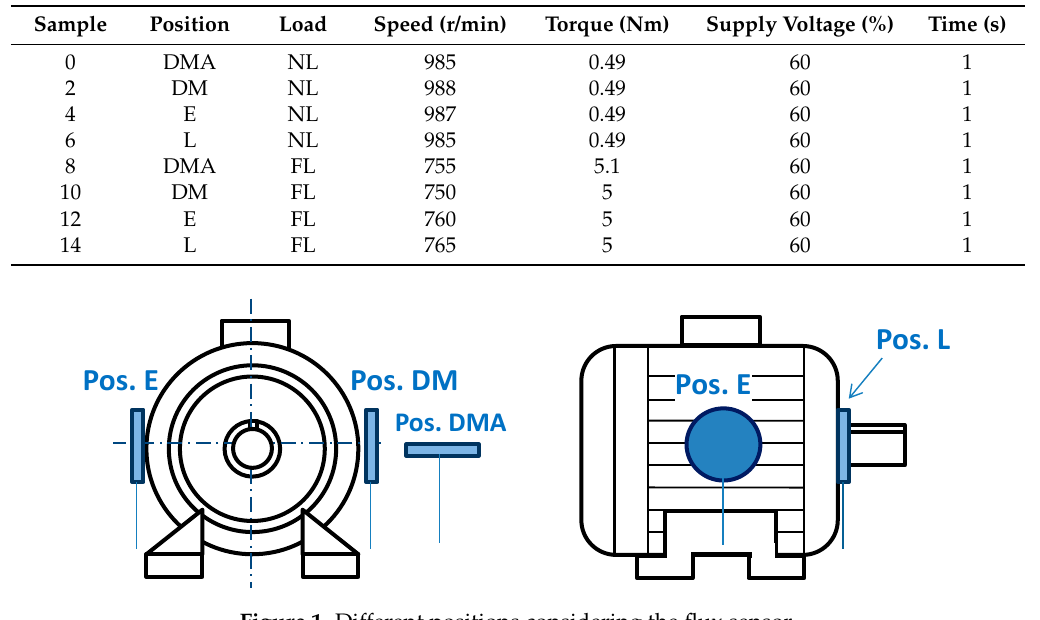
Figure 1. Different positions considering the flux sensor.